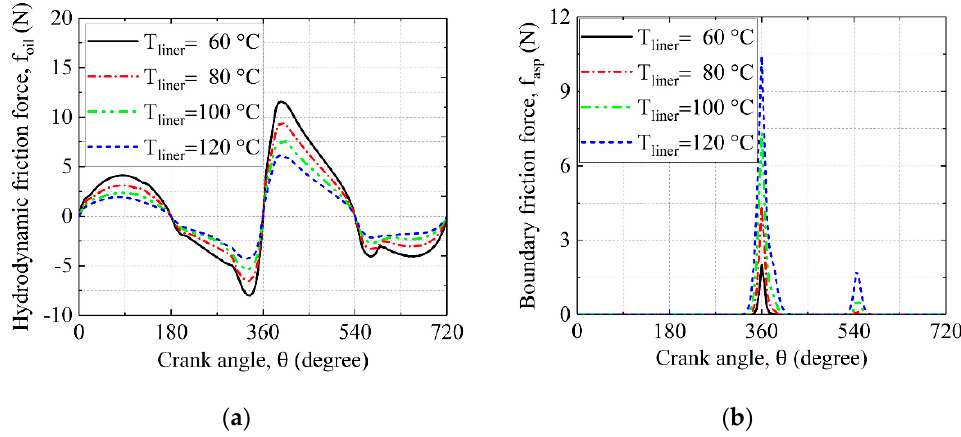
Figure 14. Friction forces in the groove textured RLC for different liner temperatures: ( a ) Hydrodynamic friction force; ( b ) boundary friction force.